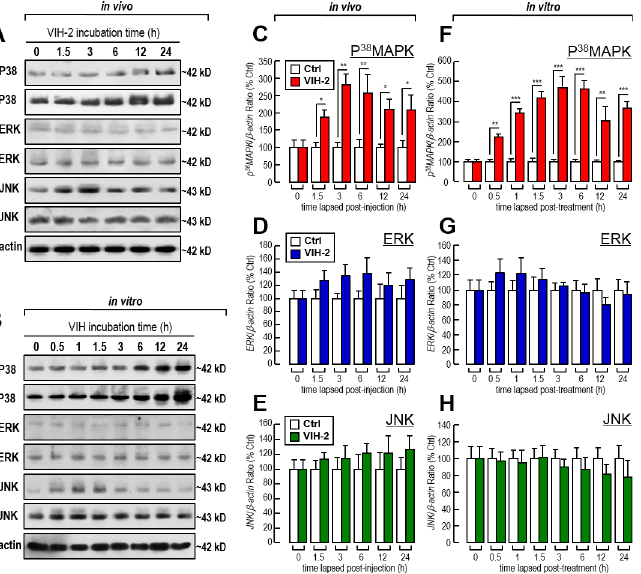
Fig 5. Effects of VIH-2 administration on the phosphorylation and mRNA expression of three MAPKs in the hepatopancreas of L . vannamei . A: Effects of VIH-2 injection on the phosphorylation of P 38 MAPK, ERK and JNK in shrimp hepatopancreas. B: Effects of VIH-2 treatment on the phosphorylation of P 38 MAPK, ERK and JNK in shrimp hepatopancreatic cell cultures. C-E: Effects of VIH-2 injection on the P 38 MAPK (C), ERK (D) and JNK (E) mRNA expressions in the shrimp hepatopancreas. F-H: Effects of VIH-2 treatment on the P 38 MAPK (F), ERK (G) and JNK (H) mRNA expression in shrimp hepatopancreatic cell cultures. For in vivo experiments, the hepatopancreas were sampled at 0, 1.5, 3, 6, 12 and 24 h after injection of VIH-2 (300 ng/g bwt). For in vitro experiments, the hepatopancreatic cells were treated with VIH-2 (1000 nM) for 0, 0.5, 1, 1.5, 3, 6, 12 and 24 h. In this study, the data presented are expressed as the mean±S.E. (n = 6 and 4 for in vivo and in vitro experiments, respectively), and significant differences between treated and untreated groups were assessed using Student’s t -test ( (cid:3) P < 0.05, (cid:3)(cid:3) P < 0.01 and (cid:3)(cid:3)(cid:3) P < 0.001).